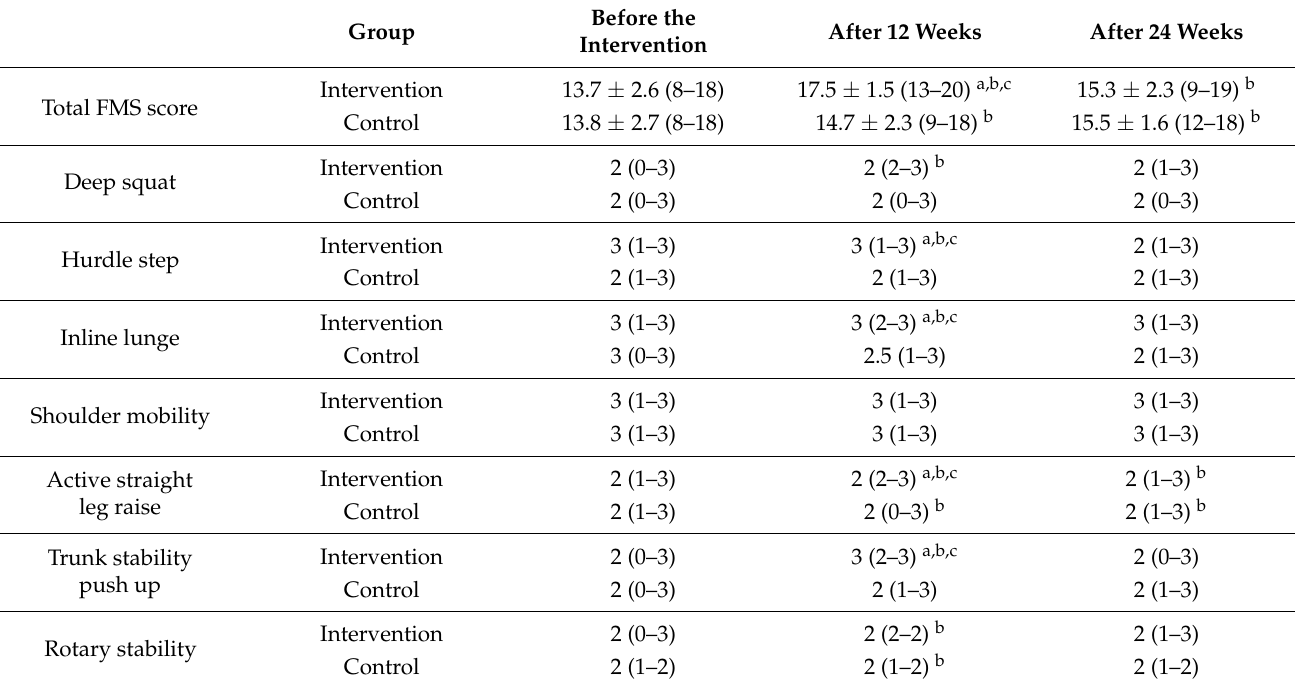
Table 4. Comparison of the FMS score between the intervention and control